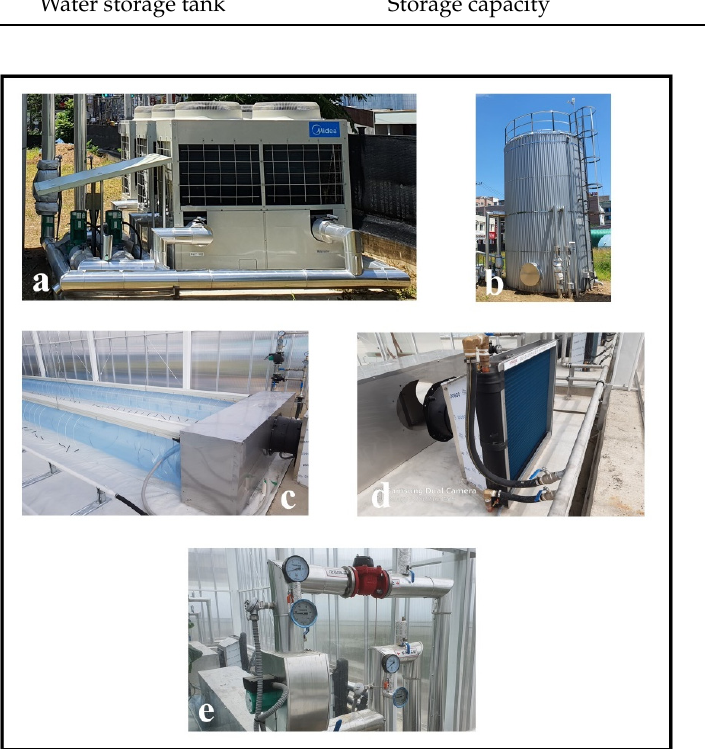
Figure 3. ( a ) AWHP; ( b ) ST; ( c ) FCU blower; ( d ) FCU; ( e ) water circulation pump and gauges inside the greenhouse.